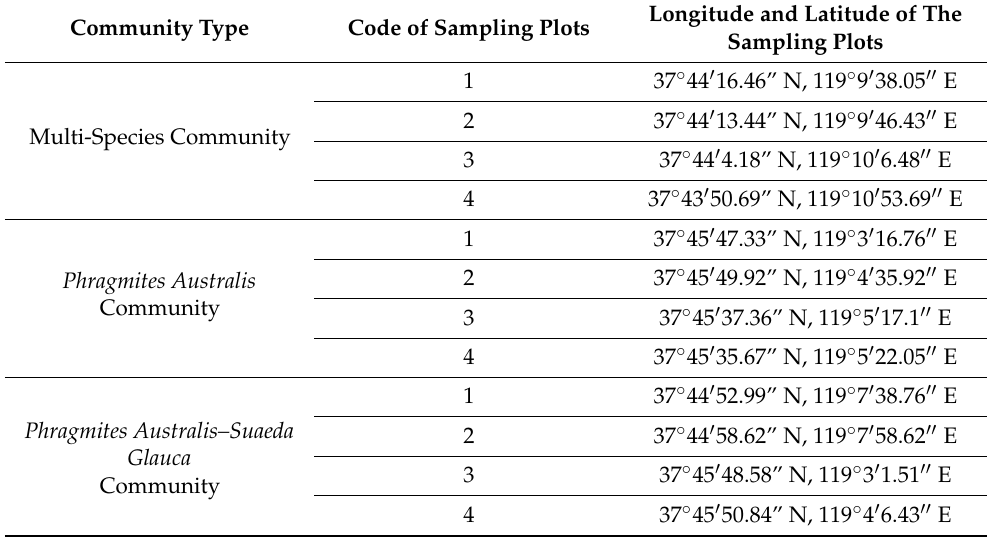
Table 1. Geographic information of the sampling plots in the Yellow River Delta. Community Type Code of Sampling Plots